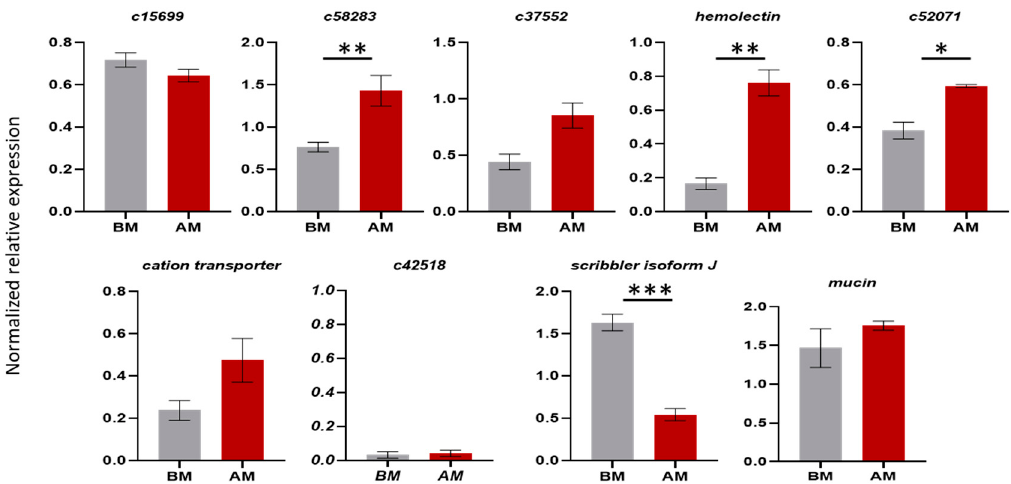
Figure 3. Comparison of the expression levels of genes expressed in male testes from Day 7 virgin insects before mating (BM) and testes from insects 12 h after one mating (AM). Mean values ± standard deviation (SD) of three biological replicates are shown. The * indicates significant differences, as determined by an unpaired Student’s t -test: p -value < 0.05 (*), p < 0.021 (**), p < 0.0002(***).